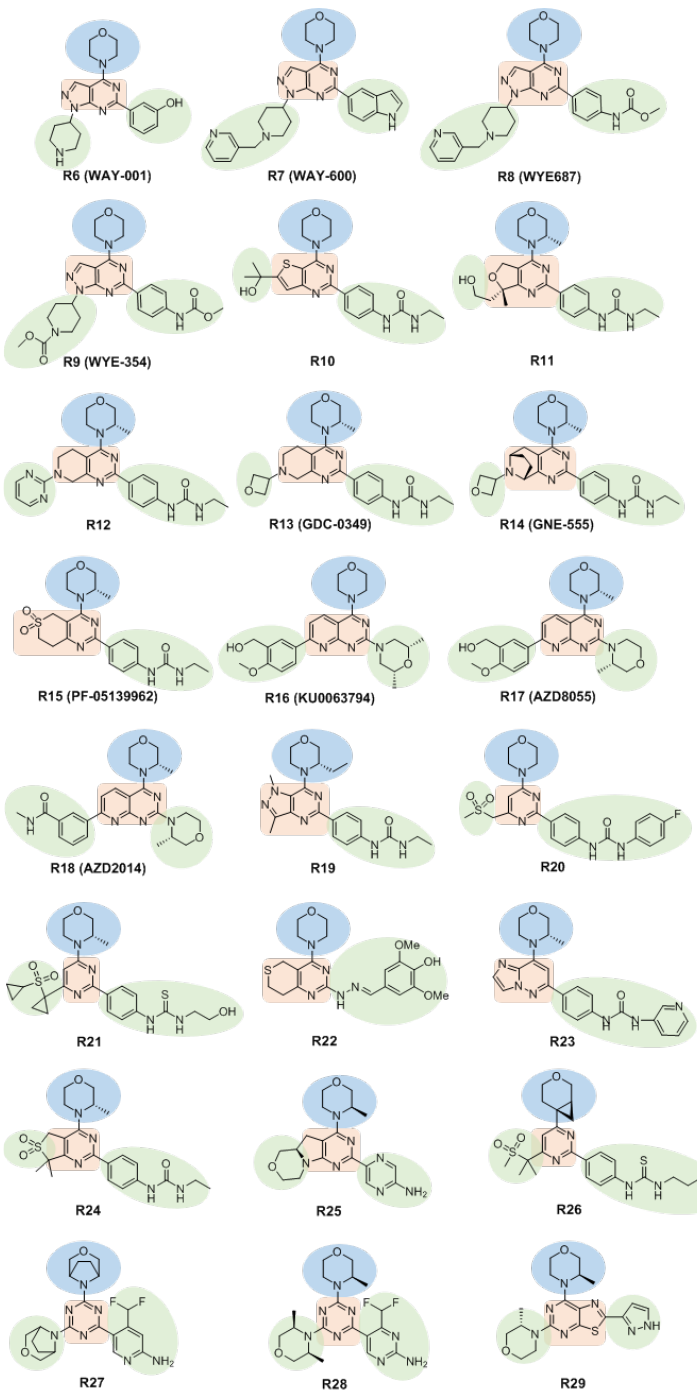
Figure 4. Structures of morpholine-substituted heterocyclic skeleton inhibitors. They are described as scaffold involving three regions: the hinge region (blue), the central region (red) and variable regions (green).